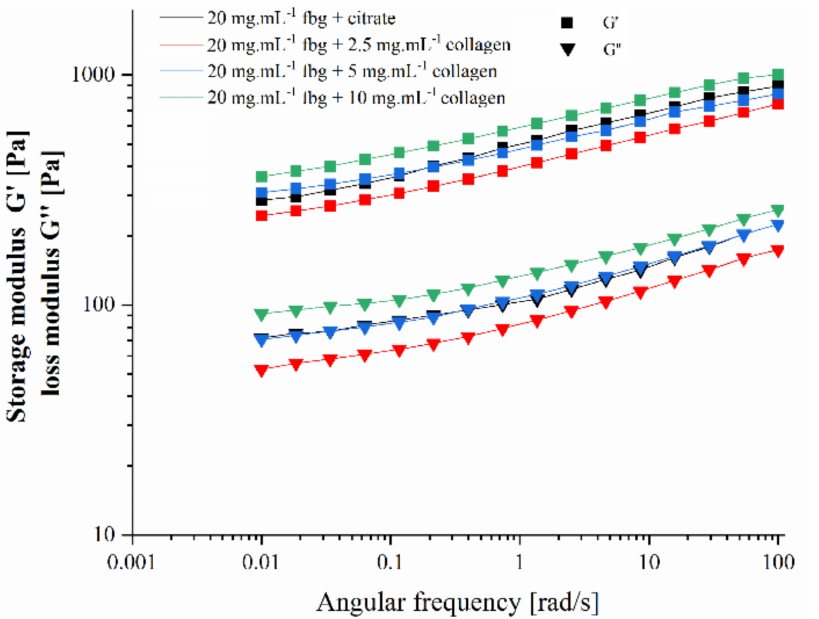
Figure 2. Variation of storage modulus G (cid:48) and loss modulus G (cid:48)(cid:48) with angular frequency of the final fibrin and fibrin-collagen